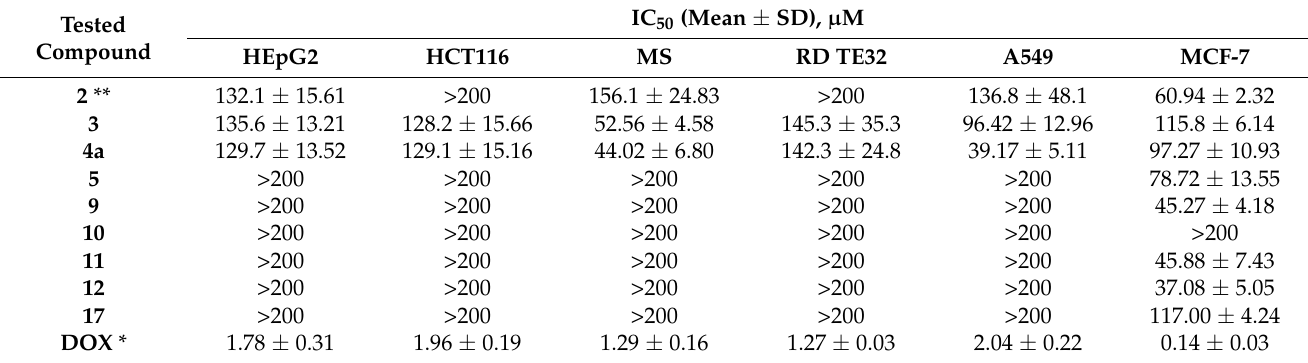
Table 2. In vitro cytotoxic activity of the compounds 2 , 3 , 4a , 5 , 9 – 12, and 17